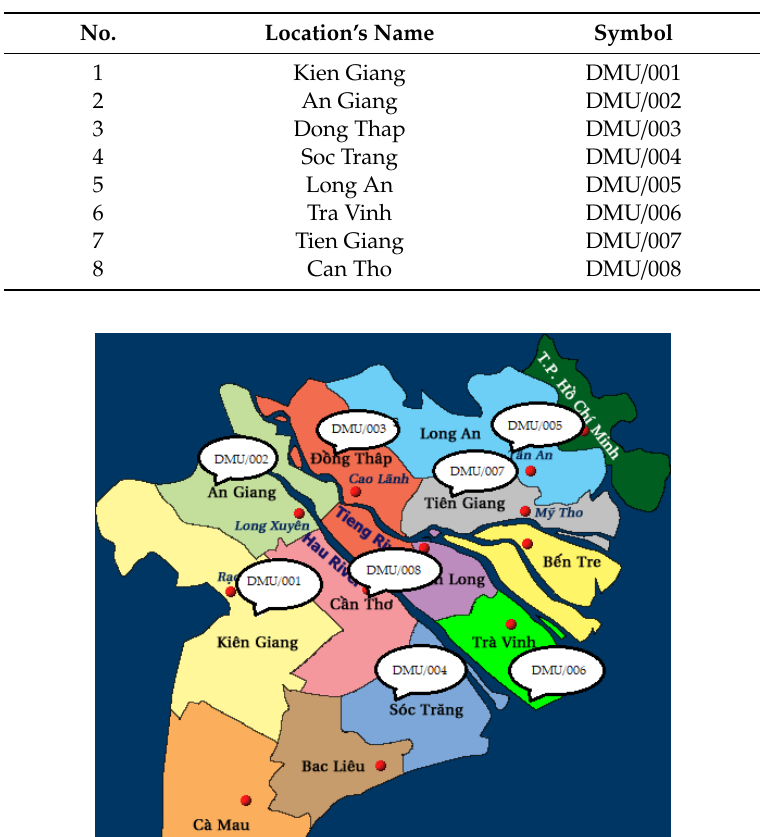
Table 1. A potential locations list. DMU—decision making unit.